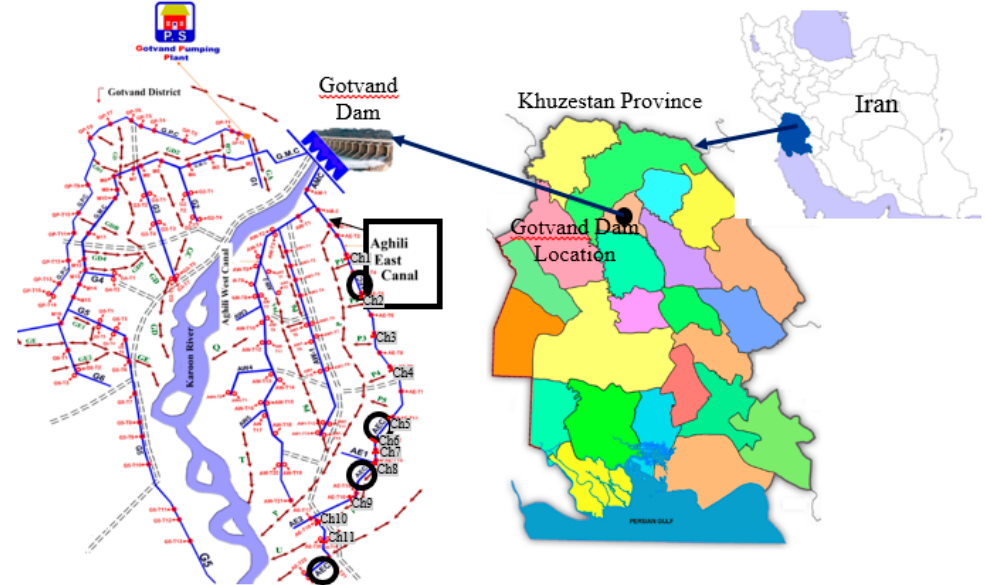
Figure 1. Layout of the East Aghili Canal on the Gotvand irrigation network.